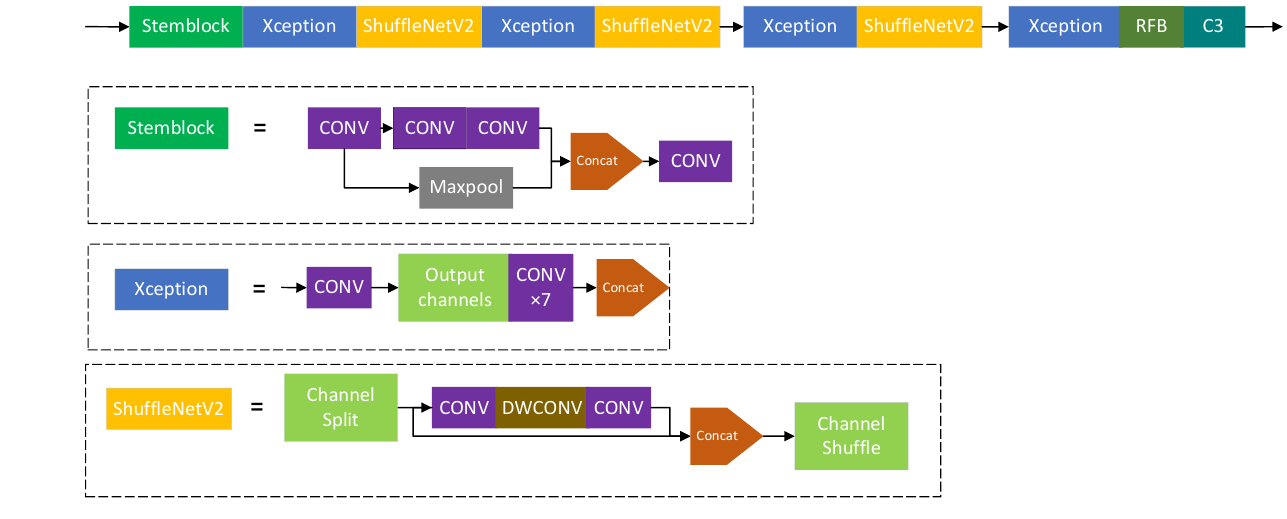
Figure 9. New backbone structure.